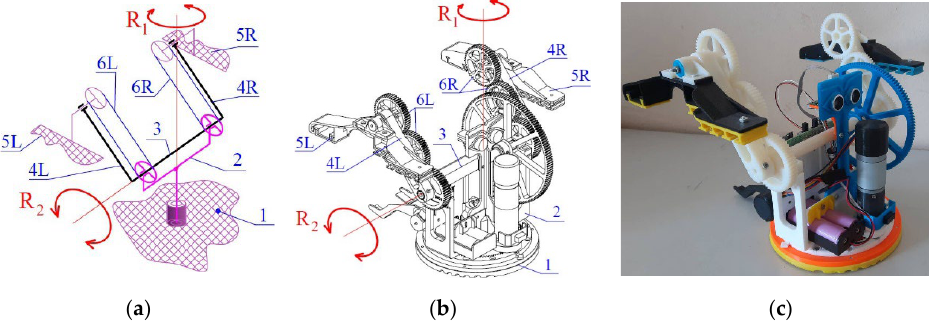
Figure 1. The robot Big Foot: principle scheme ( a ); 3D model ( b ); photo of a 3D-printed prototype ( c ).